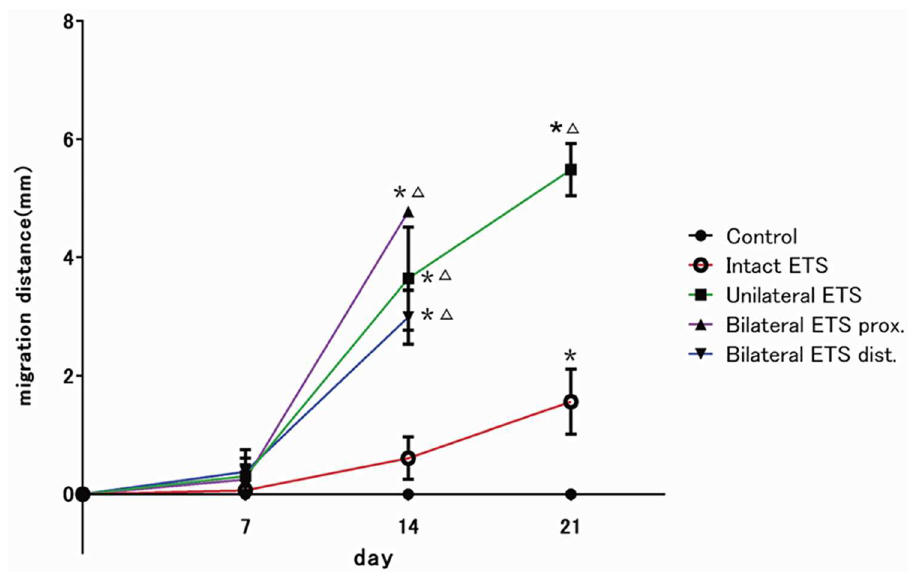
Fig 2. In vivo imaging of Schwann cell (SC) migration analysis. The mean migration distancefrom the edge of acellularnerve grafts were measuredby in vivo imaging(n = 4 per group). The significantincrease in SC migrationwas observedin all end-to-side(ETS) neurorrhaphy groups. 14 days after surgery. Partial neurectomy groups (the unilateraland bilateralETS groups) affect long migrationrather than intact ETS group. Differences betweenpartial neurectomy and intact ETS group were significant. * Significantly different from control group (p < 0.05); Δ , significantly different from unilateralETS group (p <